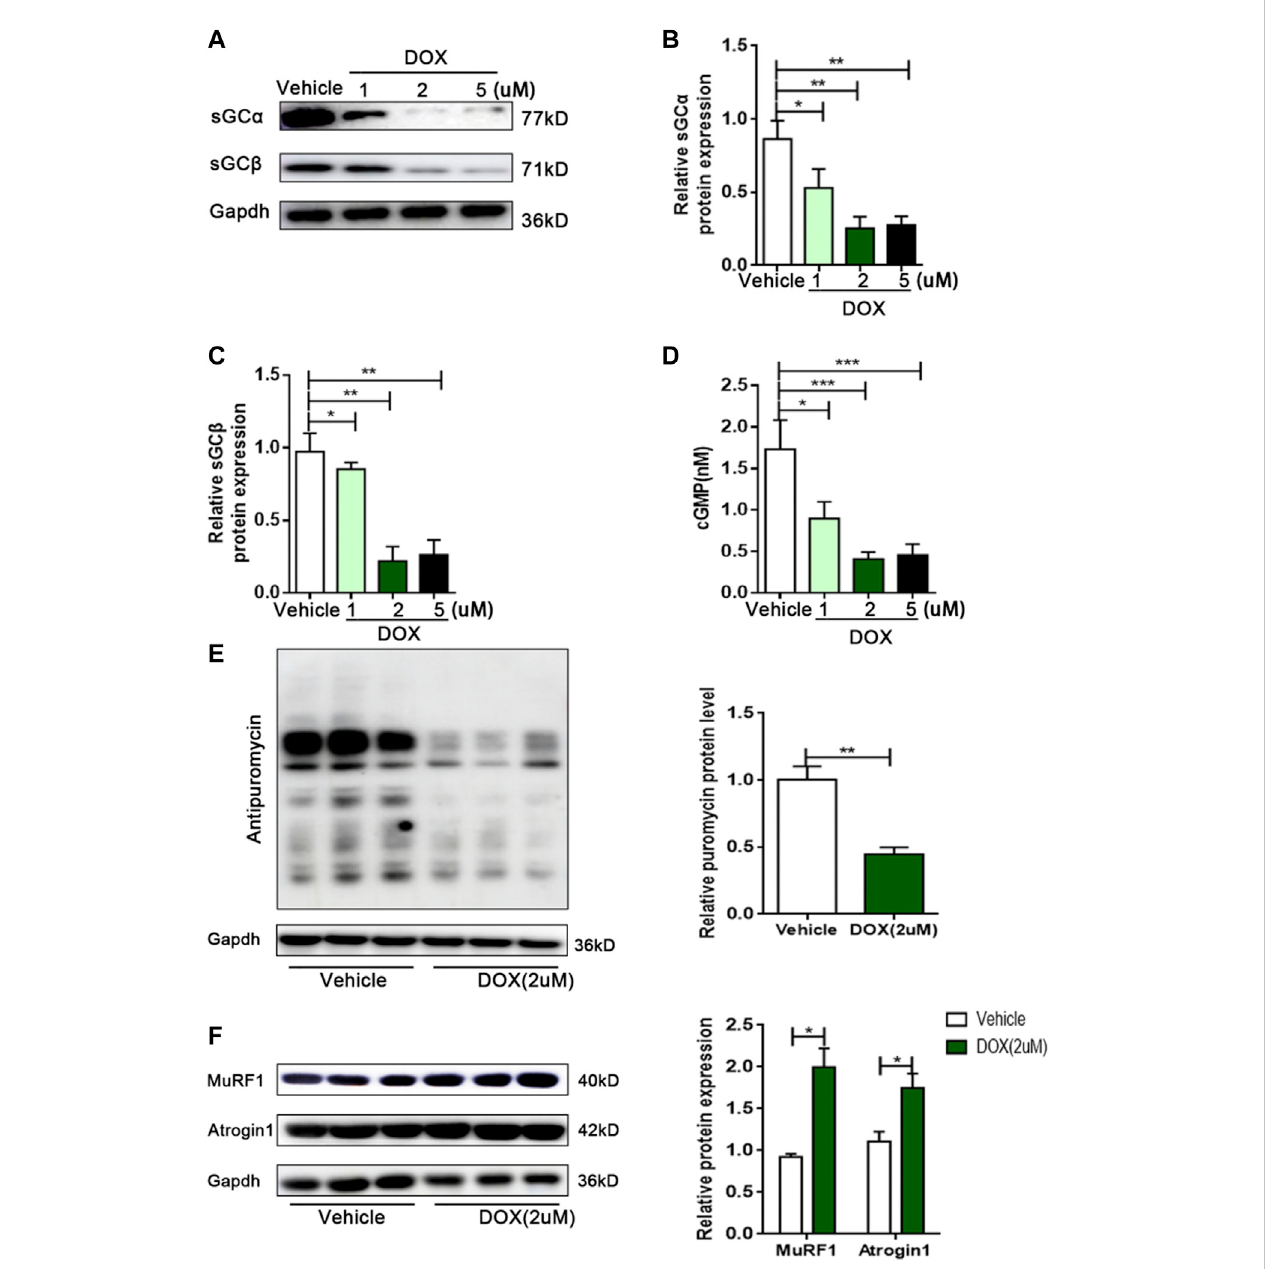
FIGURE 3 DOXleadsto decreasedsGC activity,decreased protein synthesis, and increased proteindegradationinC2C12 myotubes. (A) Representativeofwestern blotimagesofsGC α andsGC β expressionsinC2C12 cellstreatedwiththevehicleDMSOor1,2and5 μ MDOXfor24 h. (B) Quanti fi cationoftherelativelevels ofsGC α proteinsfrompanel (A) . (C) Quanti fi cationoftherelativelevelsofsGC β proteinsfrompanel (A) . (D) DetectionofcGMPcontentinC2C12myotubesby Elisa. (E) Representative immunoblots of puromycin incorporation in C2C12 myotubes treated with 2 μ M DOX. (F) Representative immunoblots of MuRF1 and Atrogin1 in C2C12 myotubes treated with 2 μ M DOX. n = 3; * p < 0.05, ** p < 0.01, *** p <